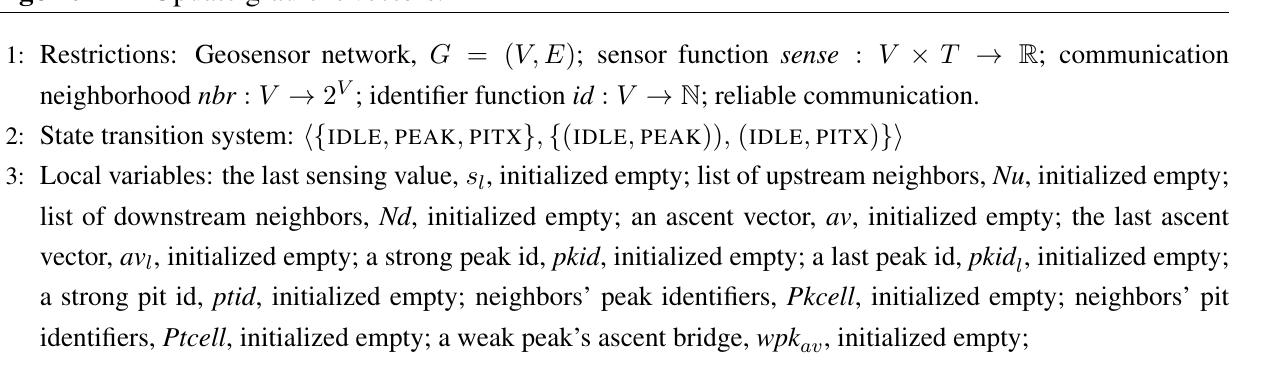
Algorithm 1 Update gradient